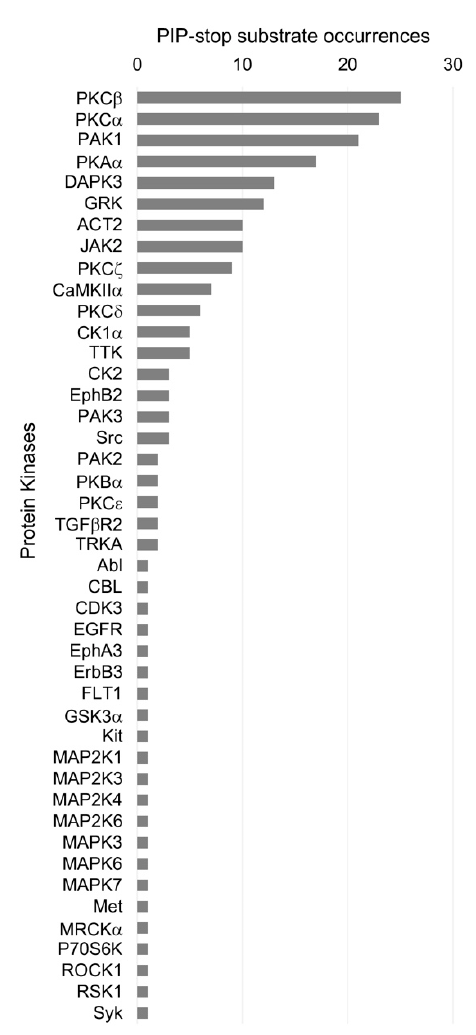
Figure 5. Protein kinases that act on PIP-stop motifs. The total number of occurrences of each human kinase which is predicted by NetworKIN and NetPhorest [105] to phosphorylate the candidate PIP-stops identified here in all human PX domains are shown.